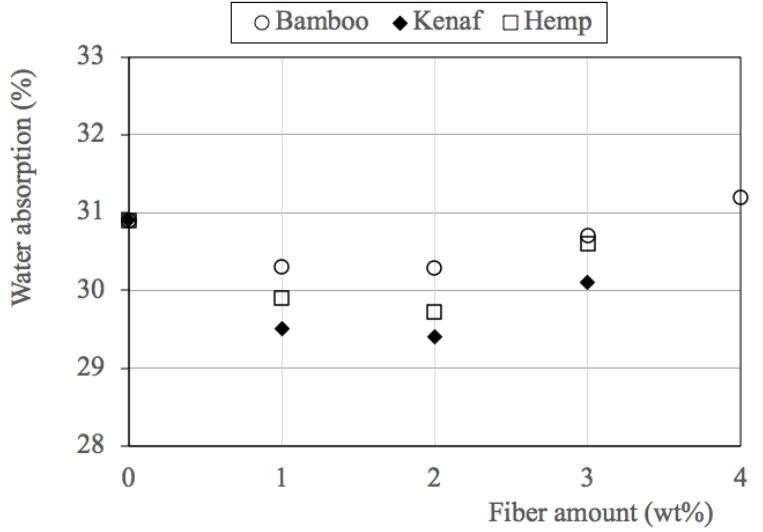
Figure 4. Absorbed water as a function of the fiber amount.